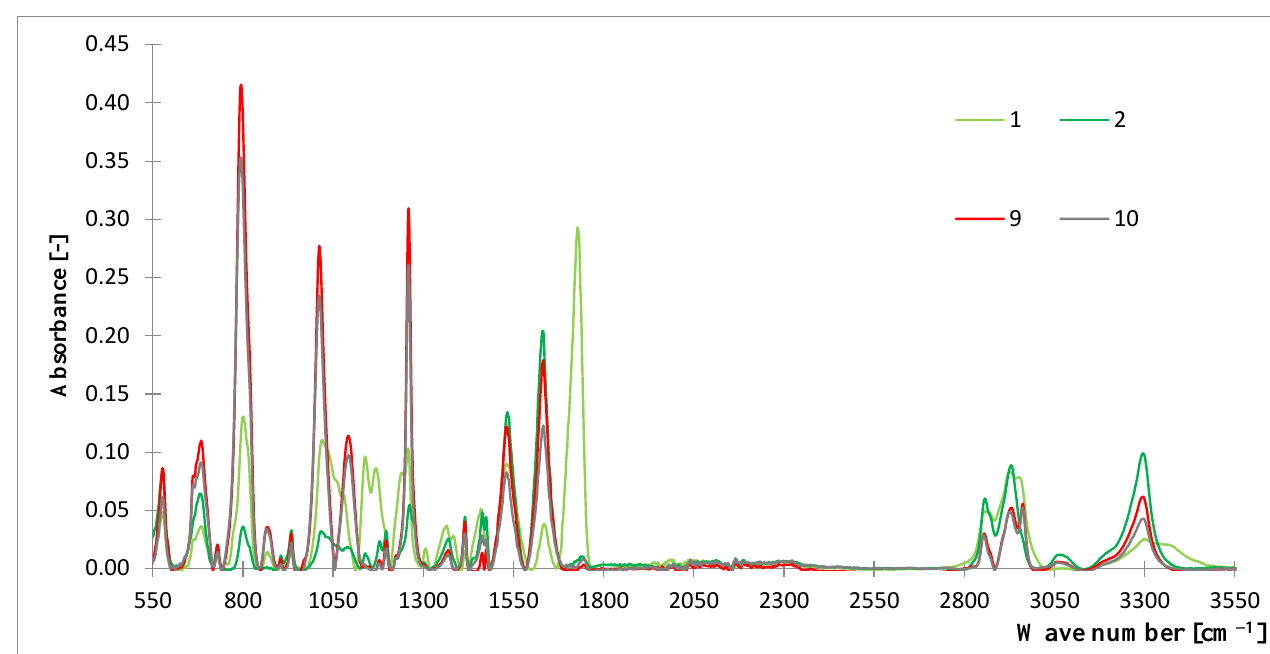
Figure 2. The FTIR spectra of the analyzed samples (no. 1 – 2, 9 – 10).